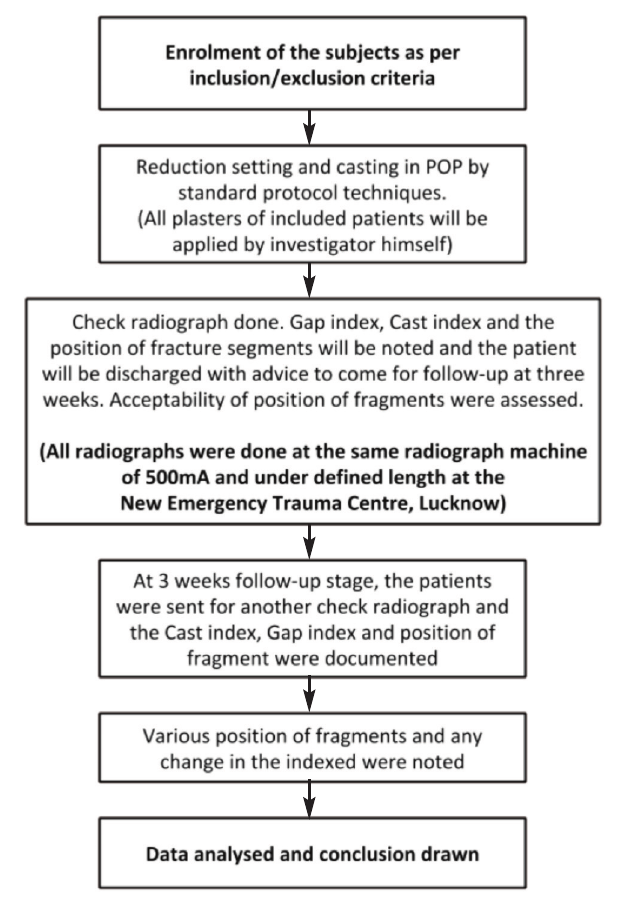
Flowchart of methodology. Fig. 1: